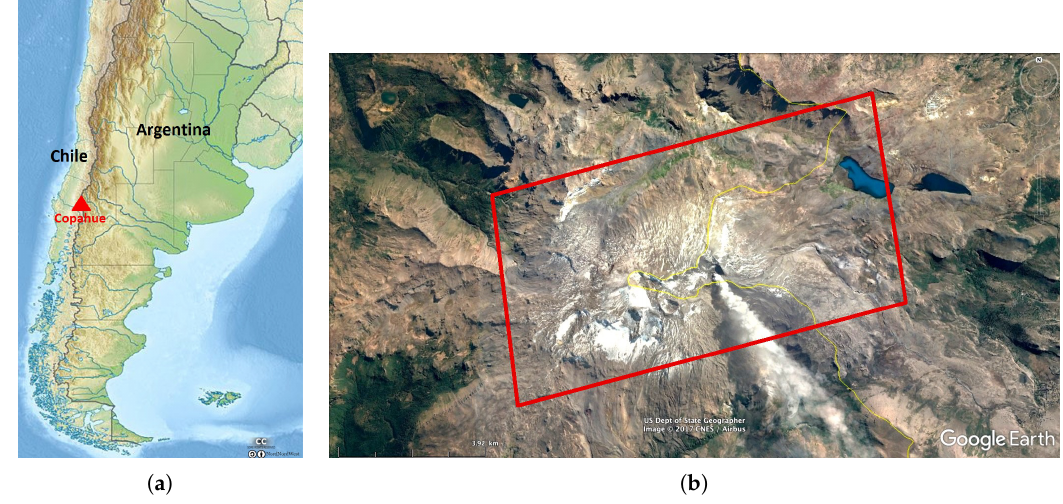
Figure 2. ( a ) Location of Copahue volcano (red triangle) on the border between Chile and Argentina. ( b ) Google Earth™ image of Copahue volcano in 2017. The footprint of the InSAR pair is drawn in